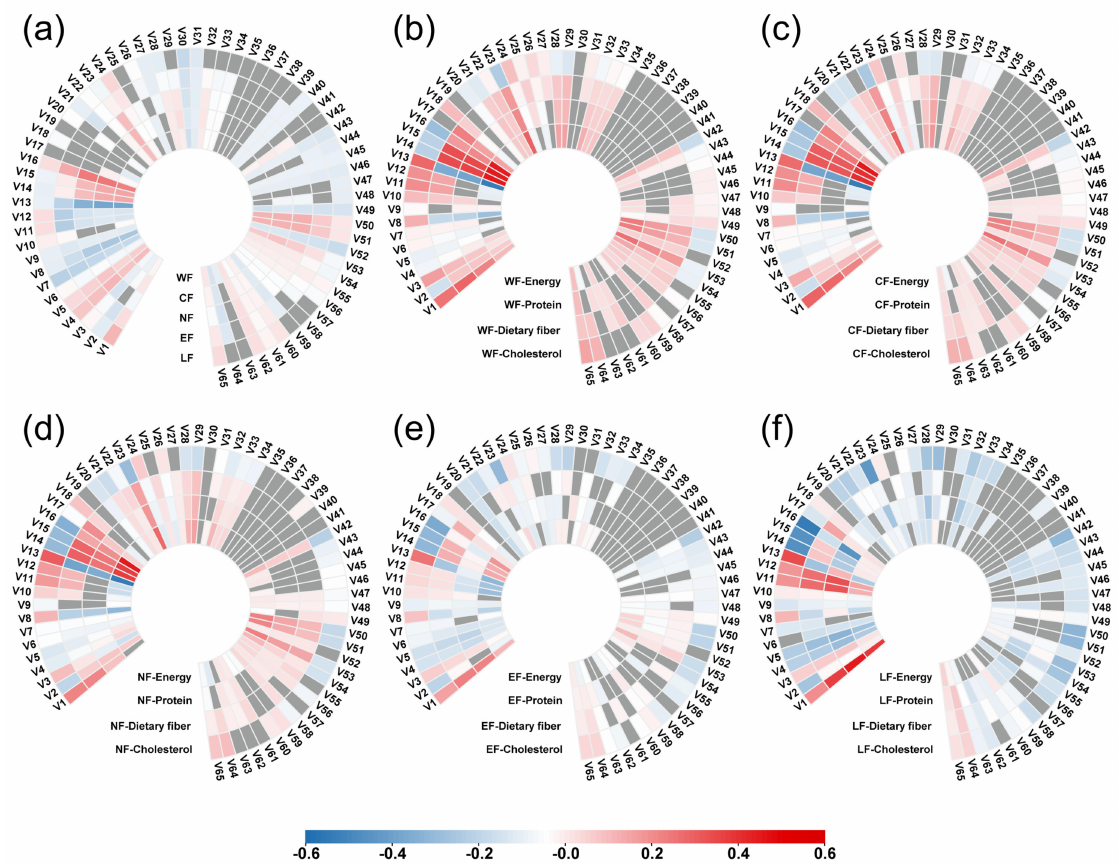
Figure 8. Correlation between multiple footprints and driving factors (Note: ( a ) Multiple footprint; ( b ) WFI; ( c ) CFI; ( d ) NFI; ( e ) EFI; ( f )